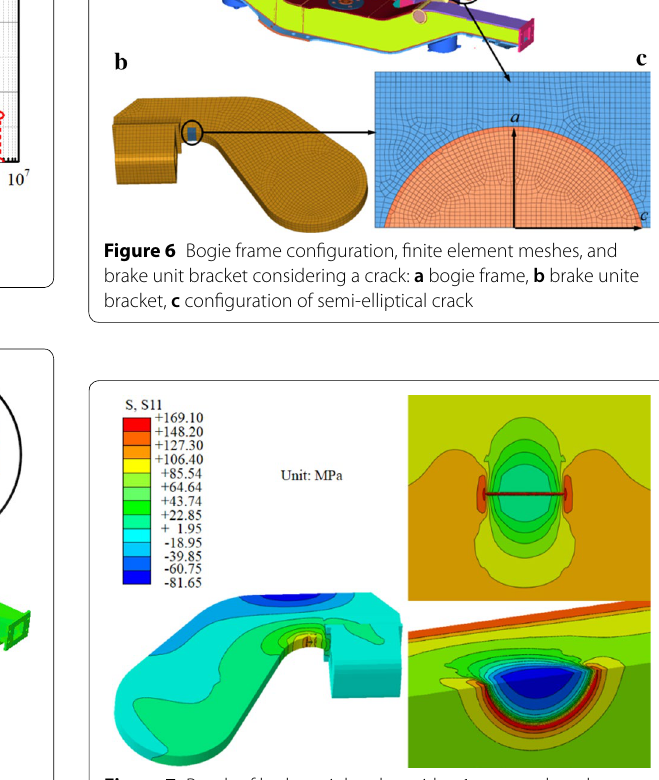
Figure 5 Stress distribution on the bogie frame under load 1